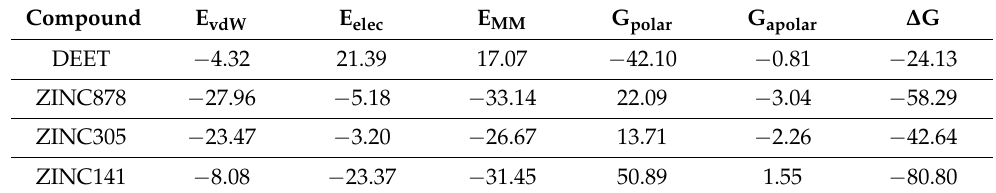
Table 2. Calculation of binding free energy by g_mmpbsa . (E vdW = van der Waals en- ergy; E elec = electrostatic energy; EMM = potential energy; G polar = polar solvation